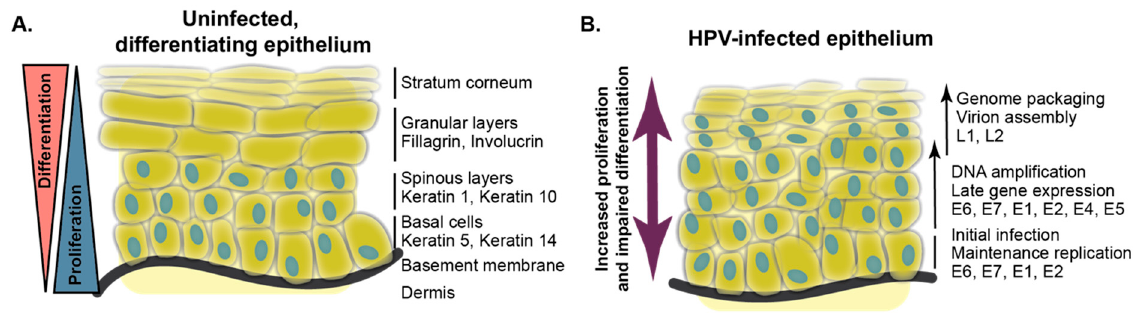
Figure 1. Human papillomavirus (HPV) replication requires and impairs epithelial di ff erentiation. A schematic of epithelial di ff erentiation in the absence ( A ) and presence ( B ) of HPV infection. In uninfected cells, self-renewing basal keratinocytes attach to the basement membrane. When keratin 5 and keratin 14-positive basal cells divide, one daughter cell can progress into the spinous layers and express keratins 1 and 10. Terminal di ff erentiation and progression into the granular and cornified layers is marked by the expression of fillagrin and involucrin. Suprabasal epithelial cells are generally not proliferative. In an HPV-infected epithelium, proliferation is uncoupled from di ff erentiation. Markers of proliferation are expressed and di ff erentiation-related gene expression is impaired in suprabasal